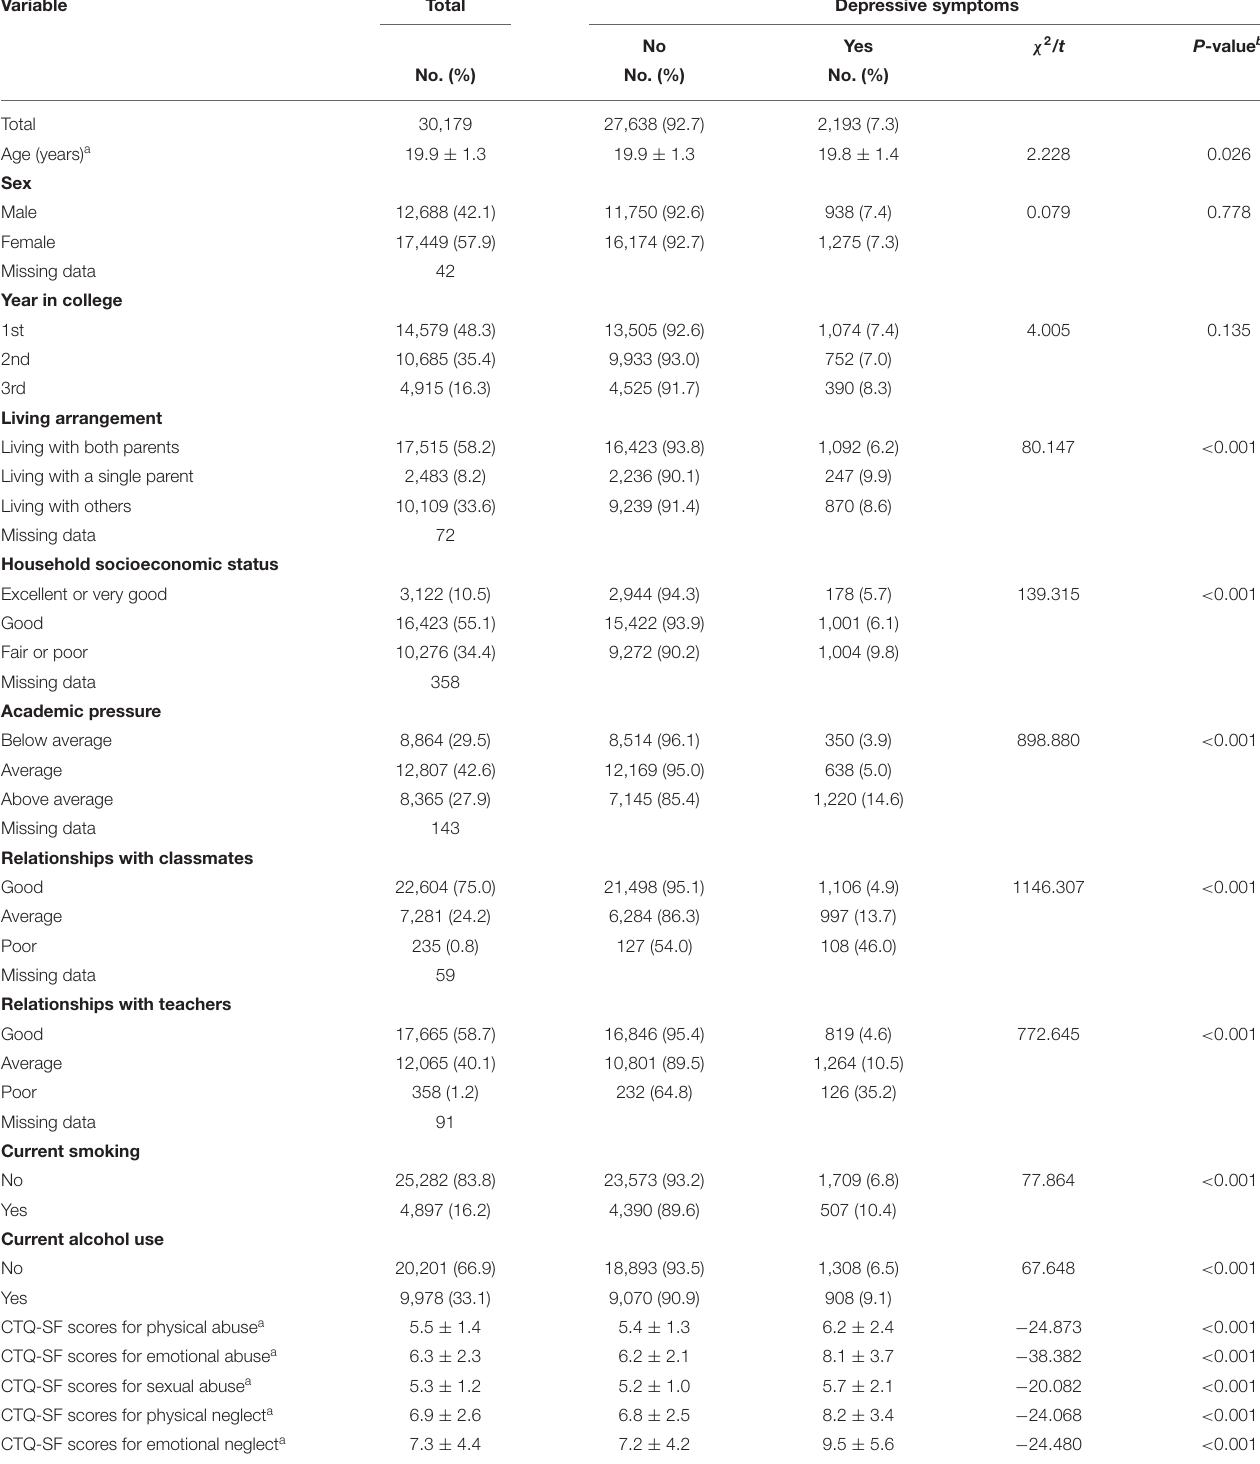
TABLE 1 | Demographic characteristics and their associations with depressive symptoms ( N = 30,179).